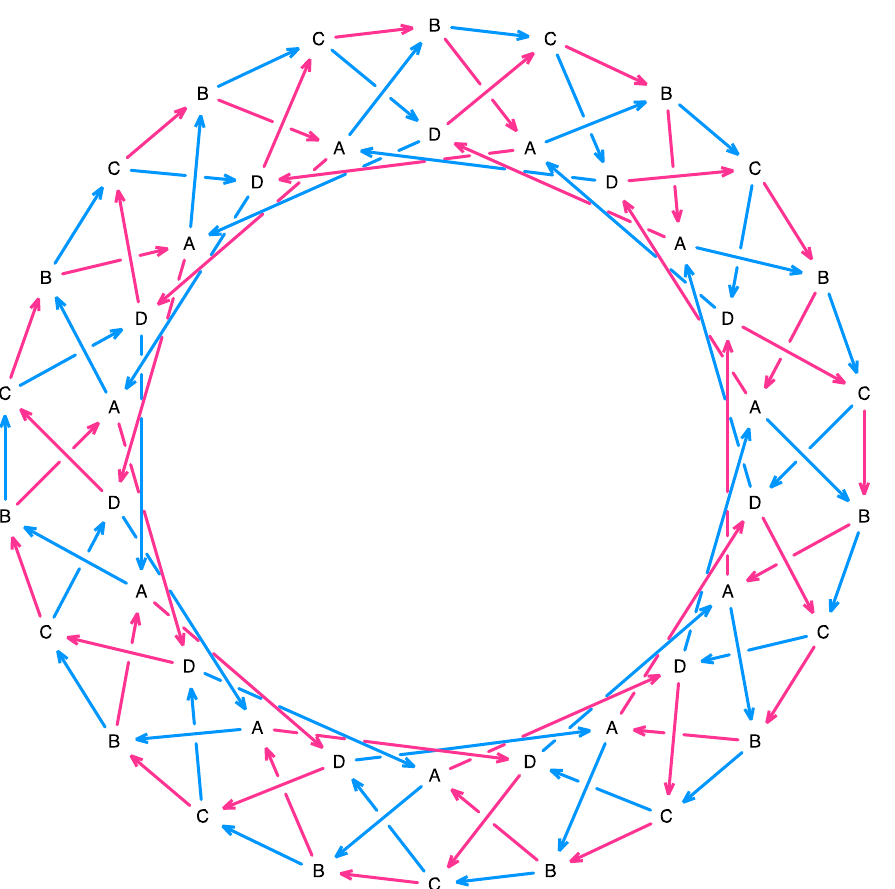
Figure 12 . The quadrality network for 2-gauge/6-(cid:13)avor